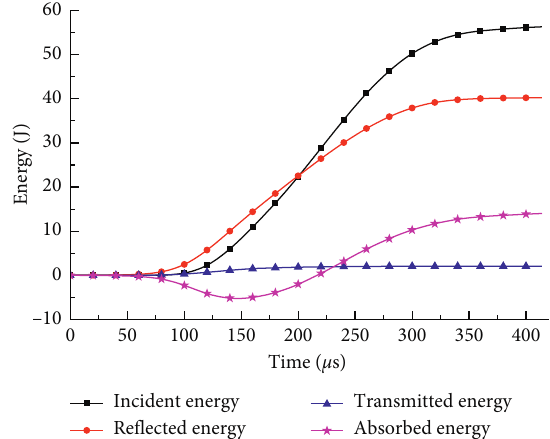
Figure 10: The energy history curve under the coupled static and dynamic state (56s − 1